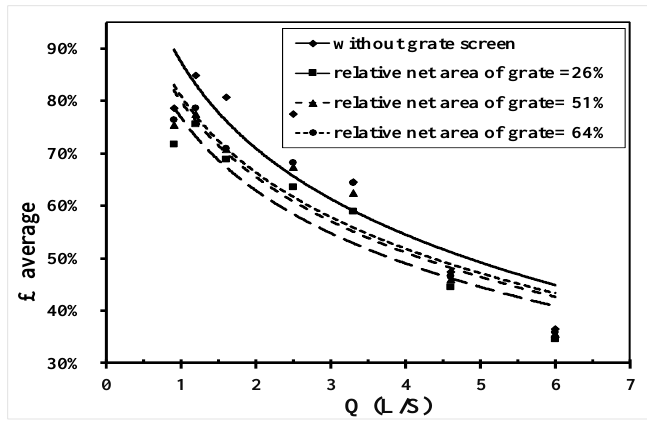
Figure 10. Relationship between discharge efficiency and passing discharge for different inlet areas.